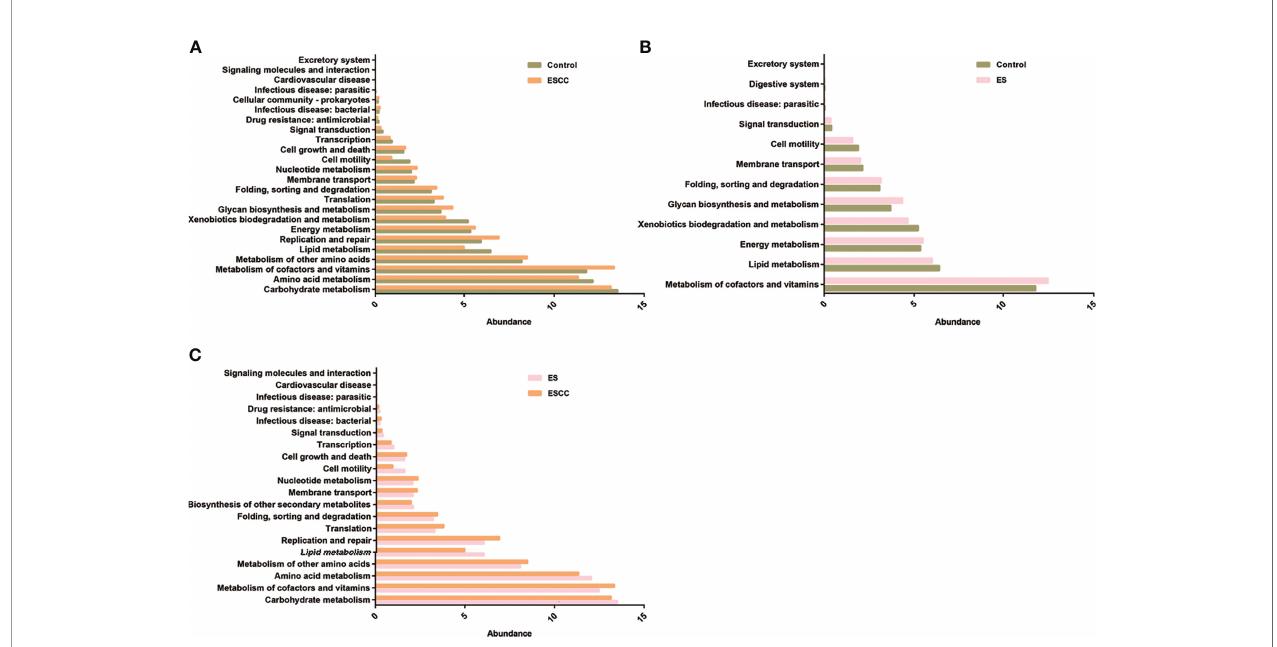
FIGURE 4 | The function prediction of the three groups. Differential Kyoto Encyclopedia of Genes and Genomes (KEGG) pathways were analyzed using PICRUSt for the three groups. Signi fi cant differences between the control and esophageal squamous cell carcinoma (ESCC) groups (A) , the control and esophagitis (ES) groups (B) , and the ES and ESCC groups (C) were